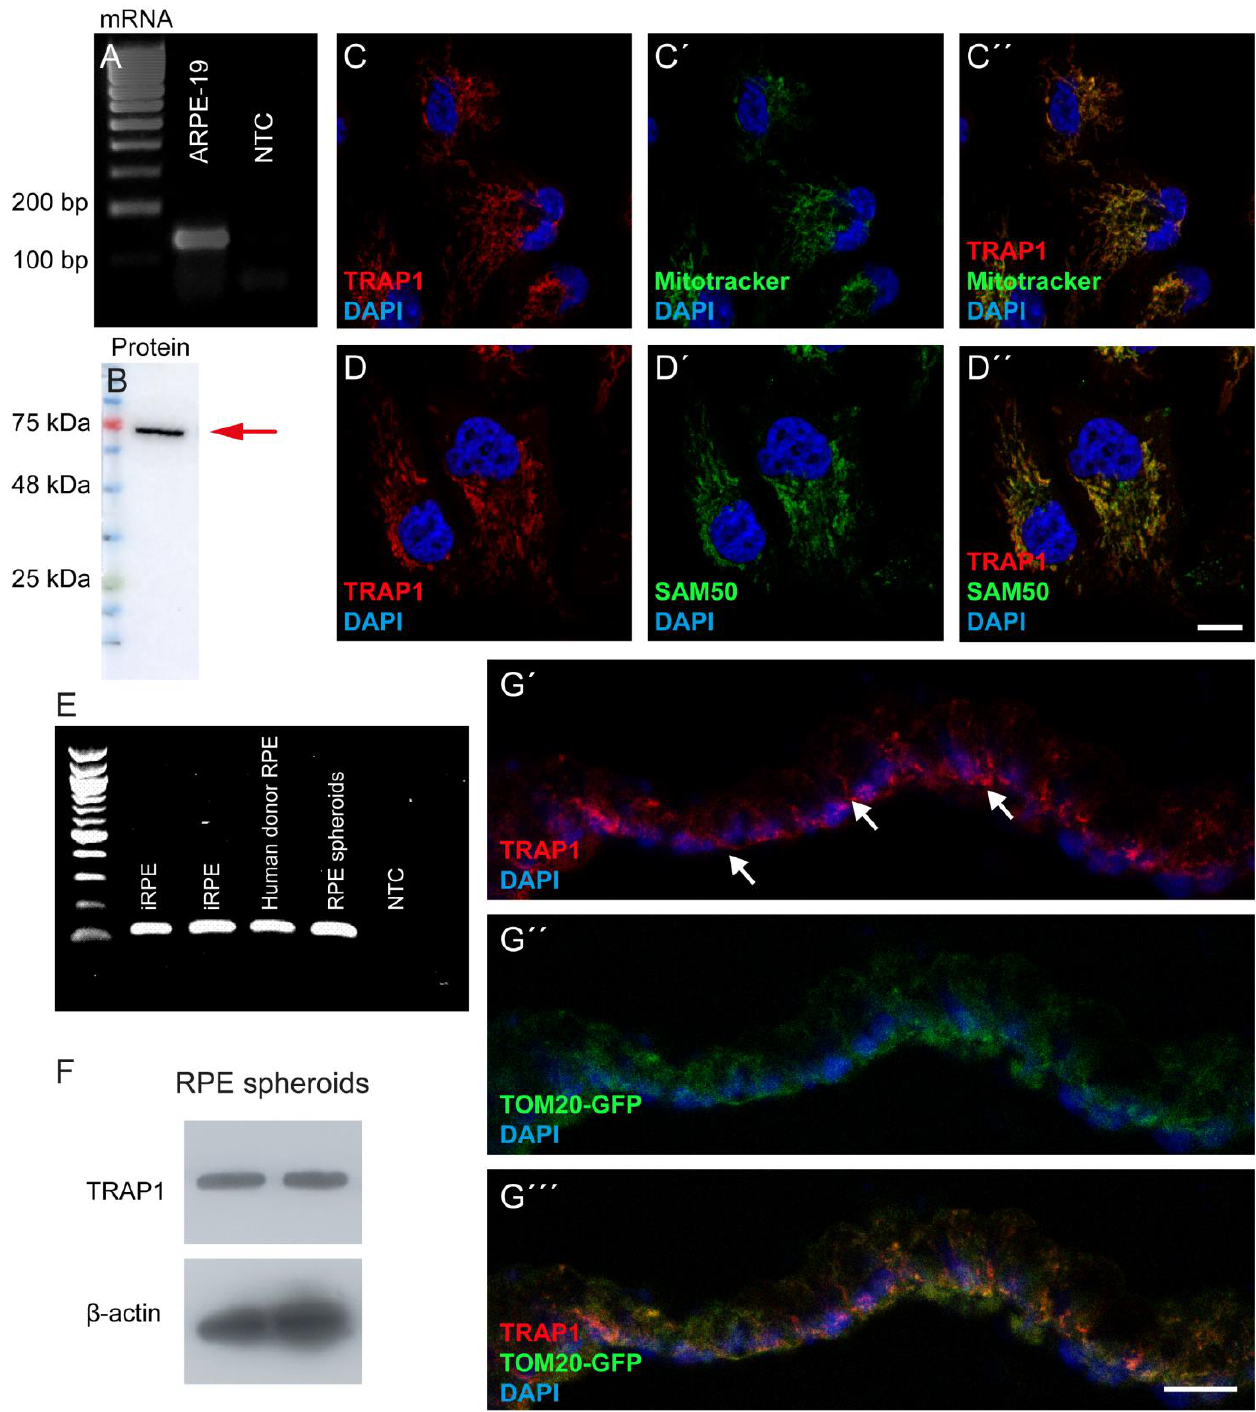
Figure 1. TRAP1 is expressed in RPE cells. TRAP1 mRNA ( A ) and protein ( B ) are expressed in human ARPE-19 cells. TRAP1 is located mainly in the mitochondria of ARPE-19 cells where it co-localizes with MitoTracker green ( C ) and the mitochondrial protein SAM50 ( D ). TRAP1 mRNA ( E ) is also expressed in iPSC-derived RPE cells (iRPE, two different lines), in RPE from human donors and in RPE spheroids ( E ). TRAP1 protein is also present in protein extracts from RPE spheroids (two different lines) ( F ) and co-localizes with the mitochondrial marker TOM20-GFP ( G ). NTC: Non-template control. Scale bars: 10 µm.